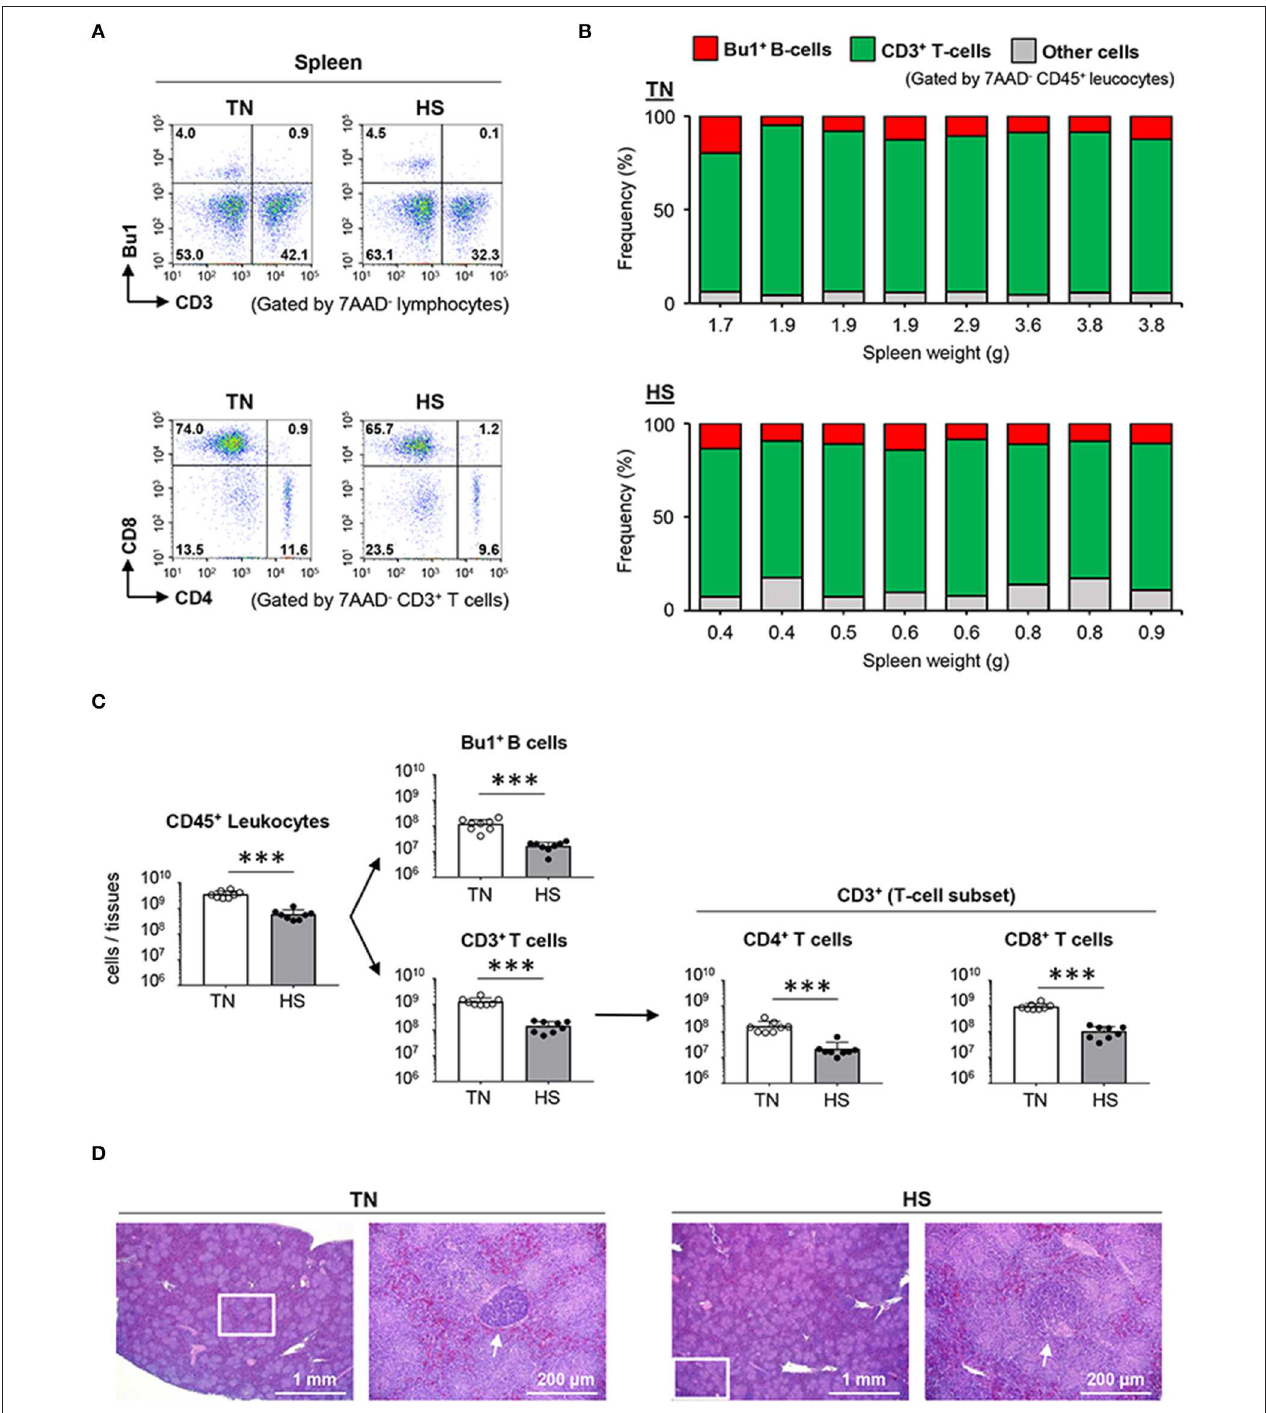
FIGURE 3 | Effect of HS on lymphocytes and the spleen morphology of broiler chickens. Broiler chickens were maintained in the TN or HS condition for 14 days (A,B) . Representative flow cytometry profiles of 7AAD − CD45 + leucocytes and 7AAD − CD3 + T cells in the spleen at 36 days of age. (C) Cell components of splenic CD45 + leucocytes, including CD3 + T cells, Bu1 + B cells, and other cells, and absolute number of splenic CD45 + leucocytes, Bu1 + B cells, CD3 + T cells, CD4 + helper T cells, and CD8 + killer T cells were analyzed by flow cytometry (D) . Representative hematoxylin and eosin-stained histological sections of spleen at 36 days of age. Scale bar: 200 µ m. Arrows: germinal center. The data are presented as means ± SE ( n = 8/group). *** p < 0.001 compared with the TN group (unpaired two-tailed Student’s t-